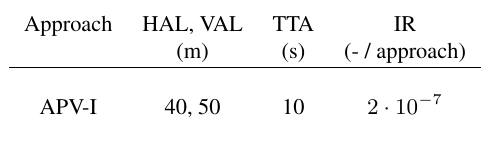
Table 1: ICAO SARPs high level integrity requirements for APV- I